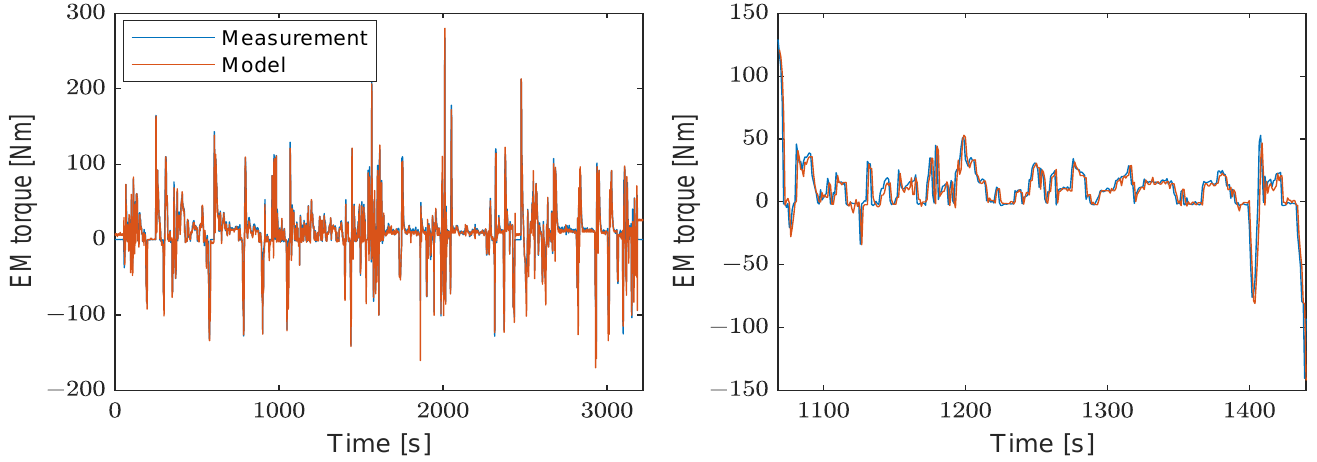
Figure A1. Validation of the EM torque for the